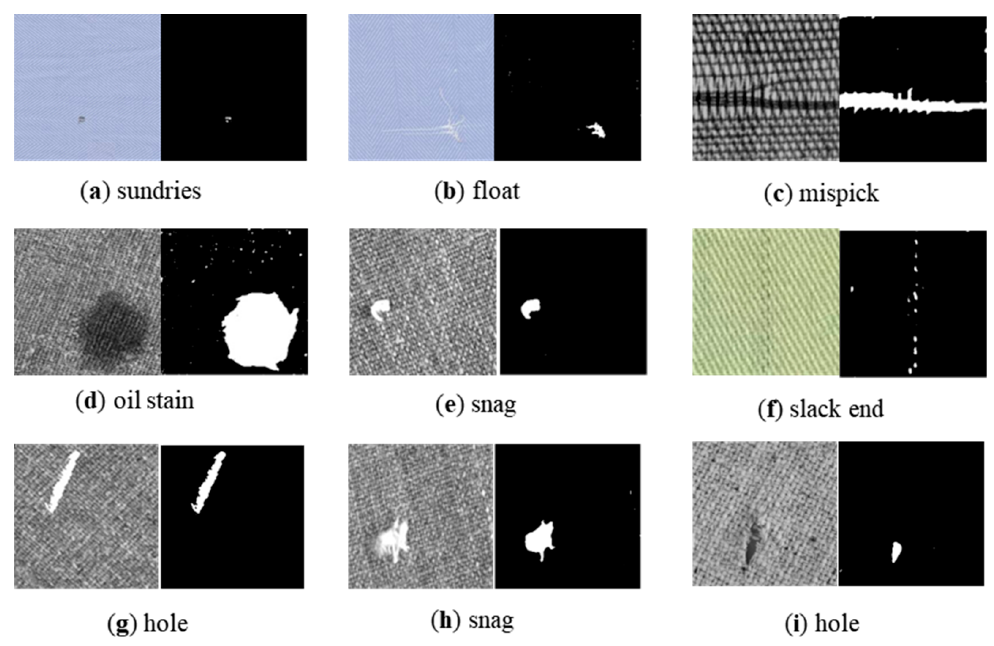
Figure 10. Twill fabric defect of detection results.